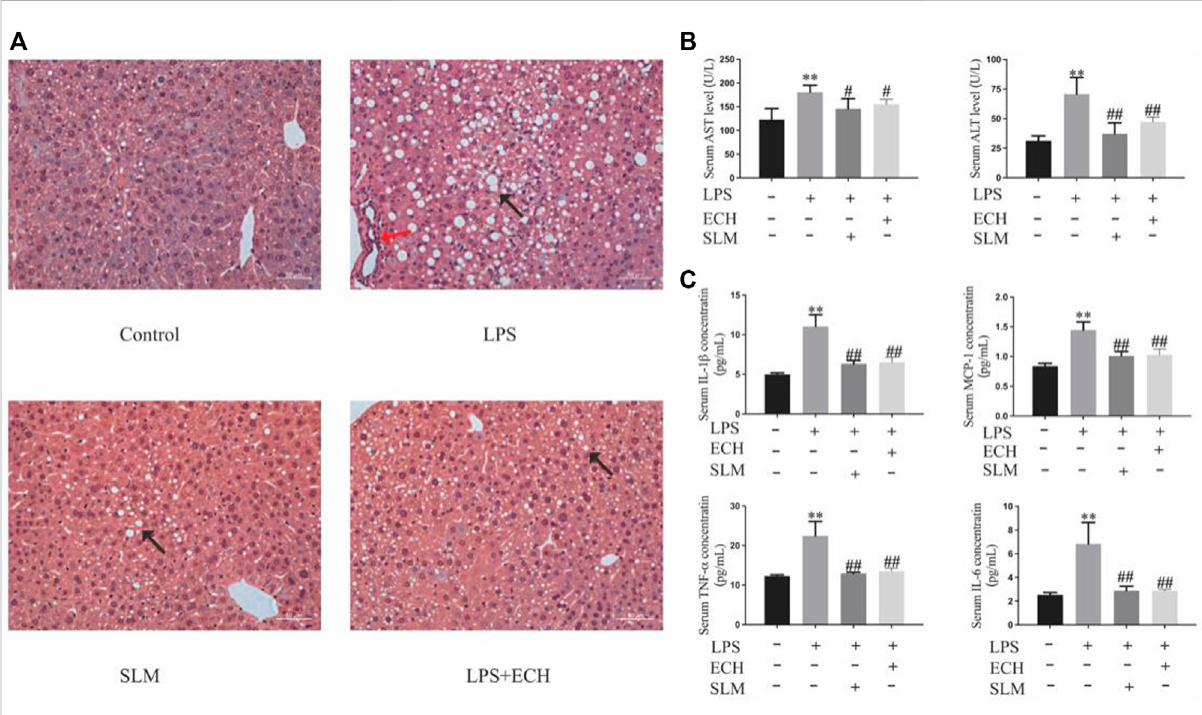
FIGURE 13 Effects of ECH on LPS-induced liver injury. (A) H&E staining of liver tissue in each group; (B) ALT and AST analysis of the serum; (C) serum levels of the in fl ammatory factors TNF- α , IL-6, IL-1 β , and MCP-1. Compared with the control group, * p < 0.05 and ** p < 0.01; in comparison with the LPS group, # P ＜ 0.05 and ##P ＜ 0.01; all data are presented as mean ± SD ( n =4 –